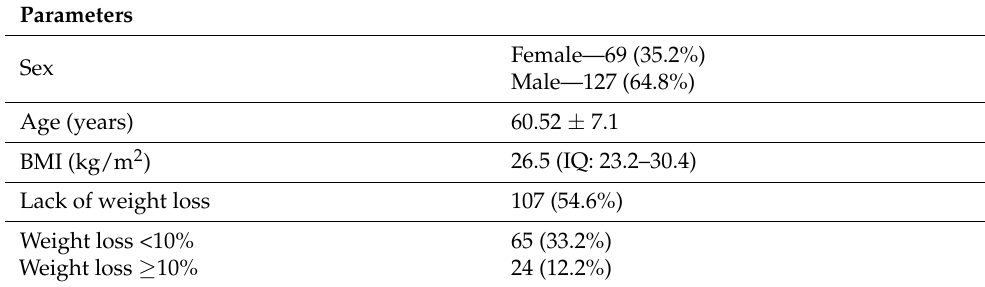
Table 1. Characteristics of patients included to the